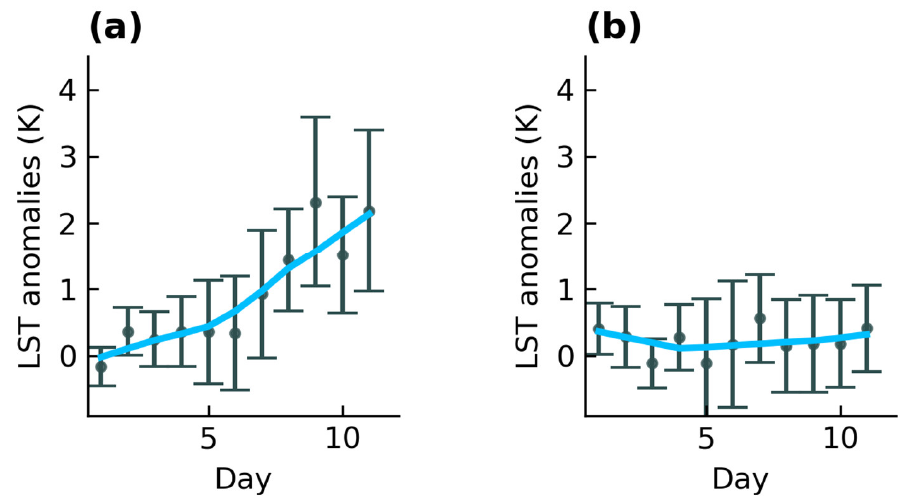
Figure 9. LST anomalies (Terra/MODIS (MOD11A1) (MXD_P85_D3) as a function of the number of days since the start of an episode for ( a ) daytime ( b ) nighttime; blue curves correspond to the lowess regression lines; error bars correspond to half standard deviation.